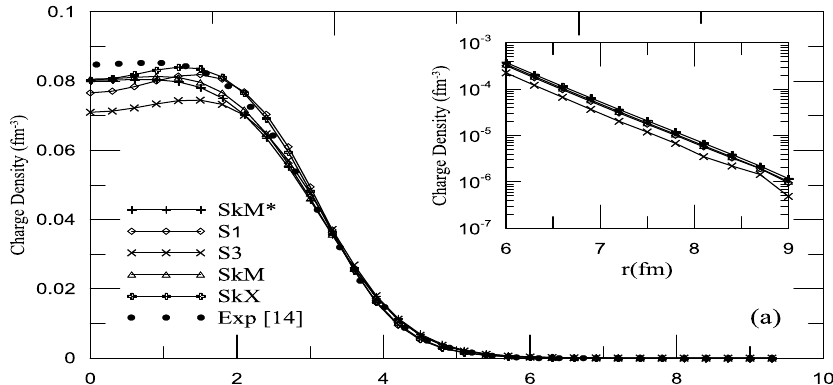
Fig. 1: Density curves of 28 Si as functions of radii calculated by different Skyrme parameterizations; (a) charge